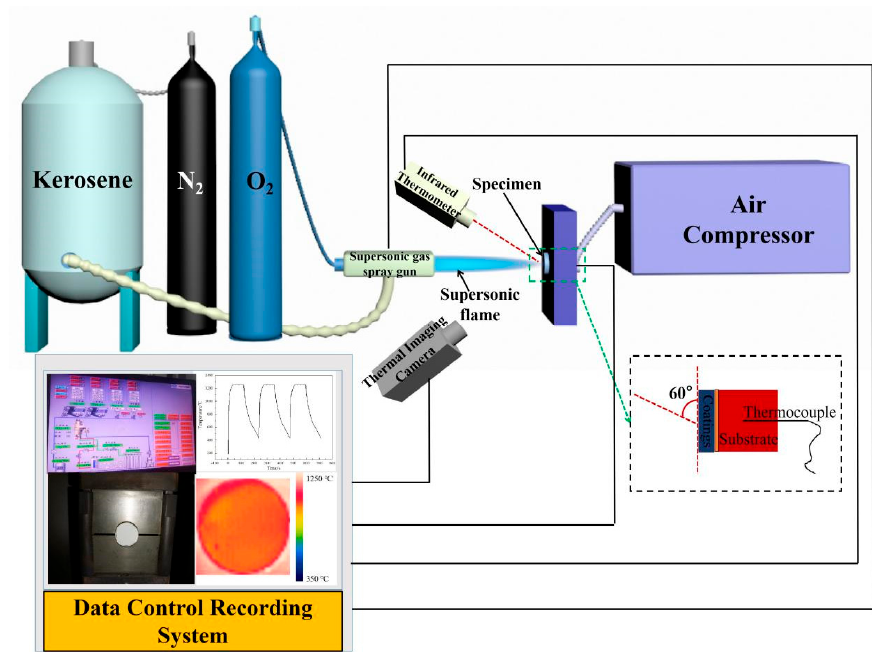
Figure 1. Schematic diagram of the environmental simulator test system.